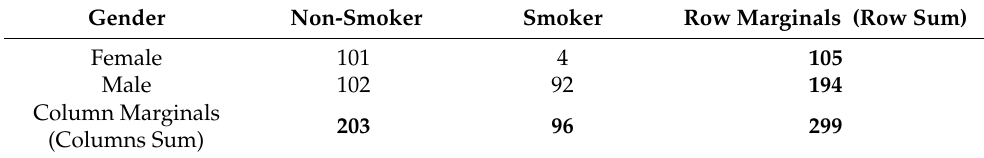
Table 9. Observed value of Gender vs. Smoking Status.